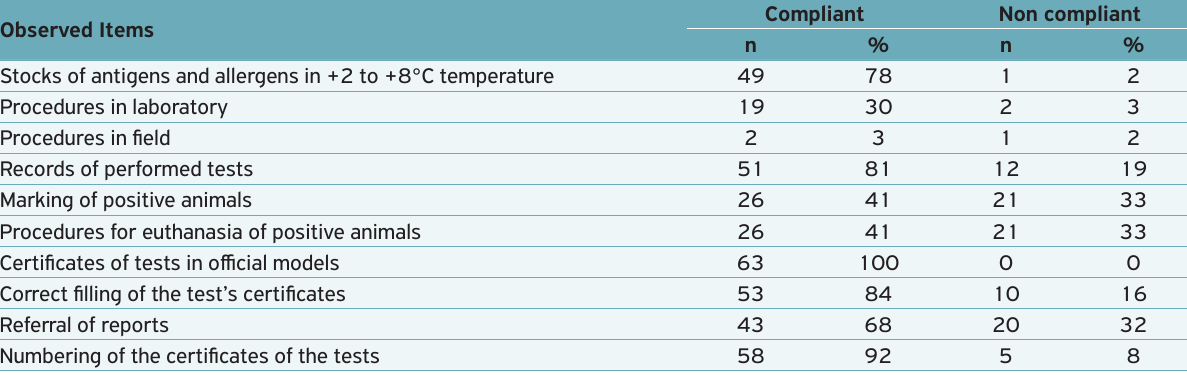
Compliant: Regular status at the Institute of Agricultural and Forestry Defense of the Espírito Santo (IDAF), based on the Normative Instruction n o 30 of 2006 and the Technical Manual of PNCEBT (Brazil, 2006a; 2006b); Non compliant: Irregular situation in IDAF.